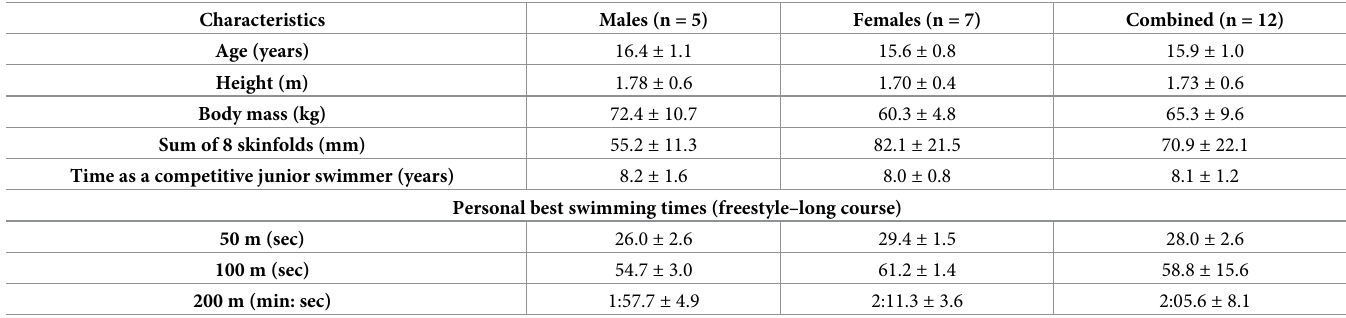
Table 1. Characteristics of study participants ( ±